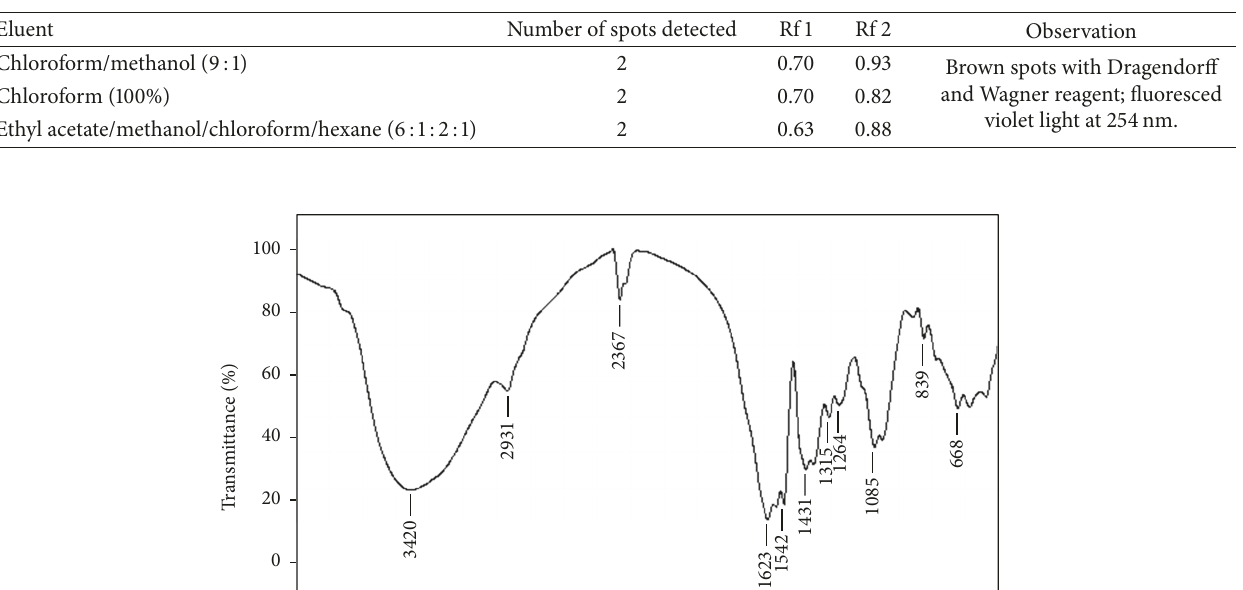
Table 6: Alkaloids analysis of O. cochenillifera mucilage by TLC.